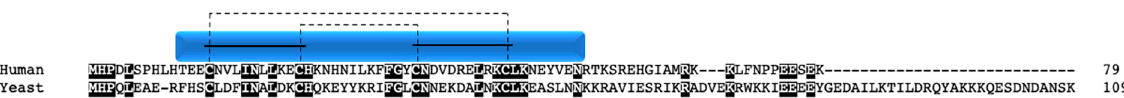
Figure 6. CMC2. Alignment of human and yeast CMC2 protein sequences. Black boxes indicate conserved residues. Human sequence annotation is as follows: Blue box indicates the CHCH domain. Solid black lines indicate the twin CX 9 C motif. Dashed lines indicate the cysteine pairs that form structural disulfide bonds.